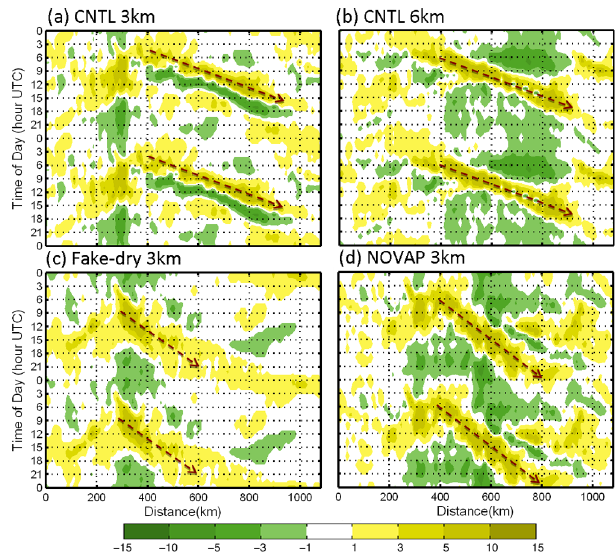
Fig. 9. Hovm¨oller diagrams of vertical velocity (cms − 1 ) at (a) 3km of CNTL; (b) 6km of CNTL; (c) 3km of Fake-dry; (d) 3km of NO- VAP averaged along the northwest–southeast cross section through ABEF. The dashed arrows show the southeastward phase propaga- tion of the